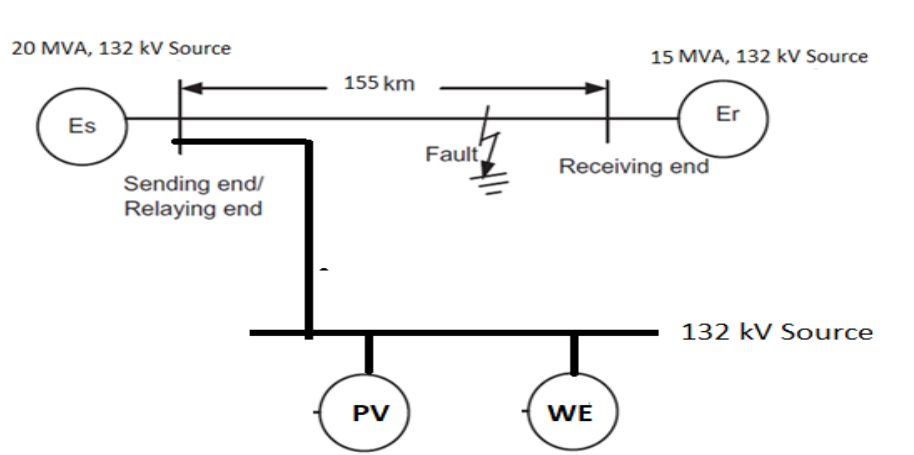
Figure 10. Integrated power system with WE and PV sources .